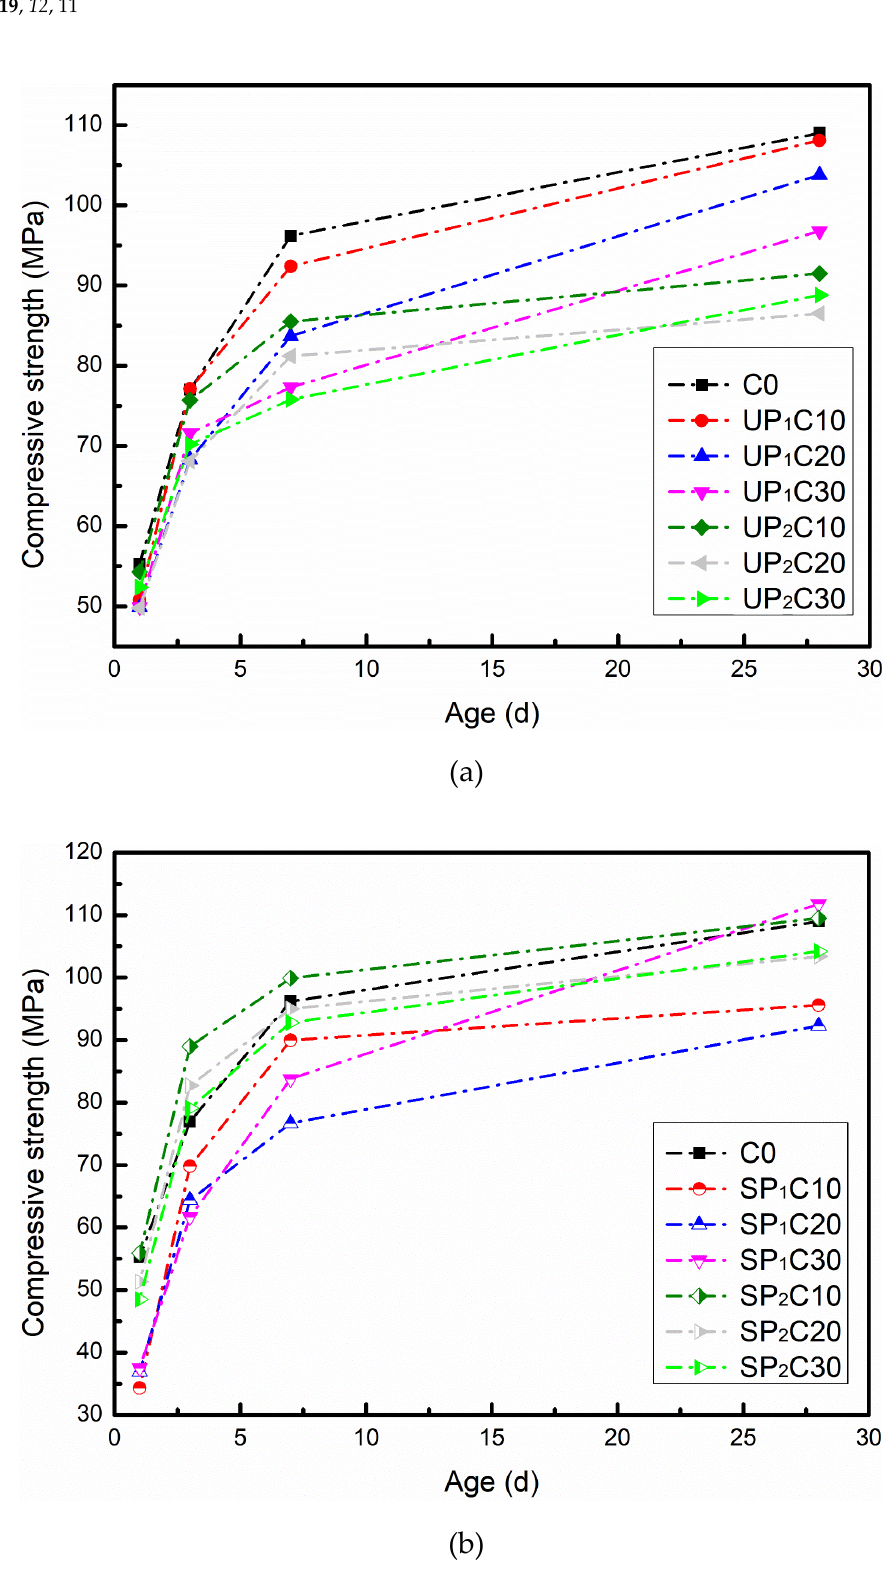
Figure 4. Compressive strength development of UHPC combined with water absorption pumice: ( a ) unsaturated pumice substitution; ( b ) saturated pumice substitution. 265